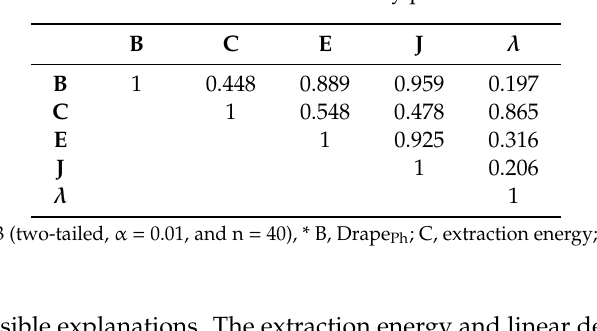
8 of 18 Figure 2. Fabric weight vs. extraction energy.